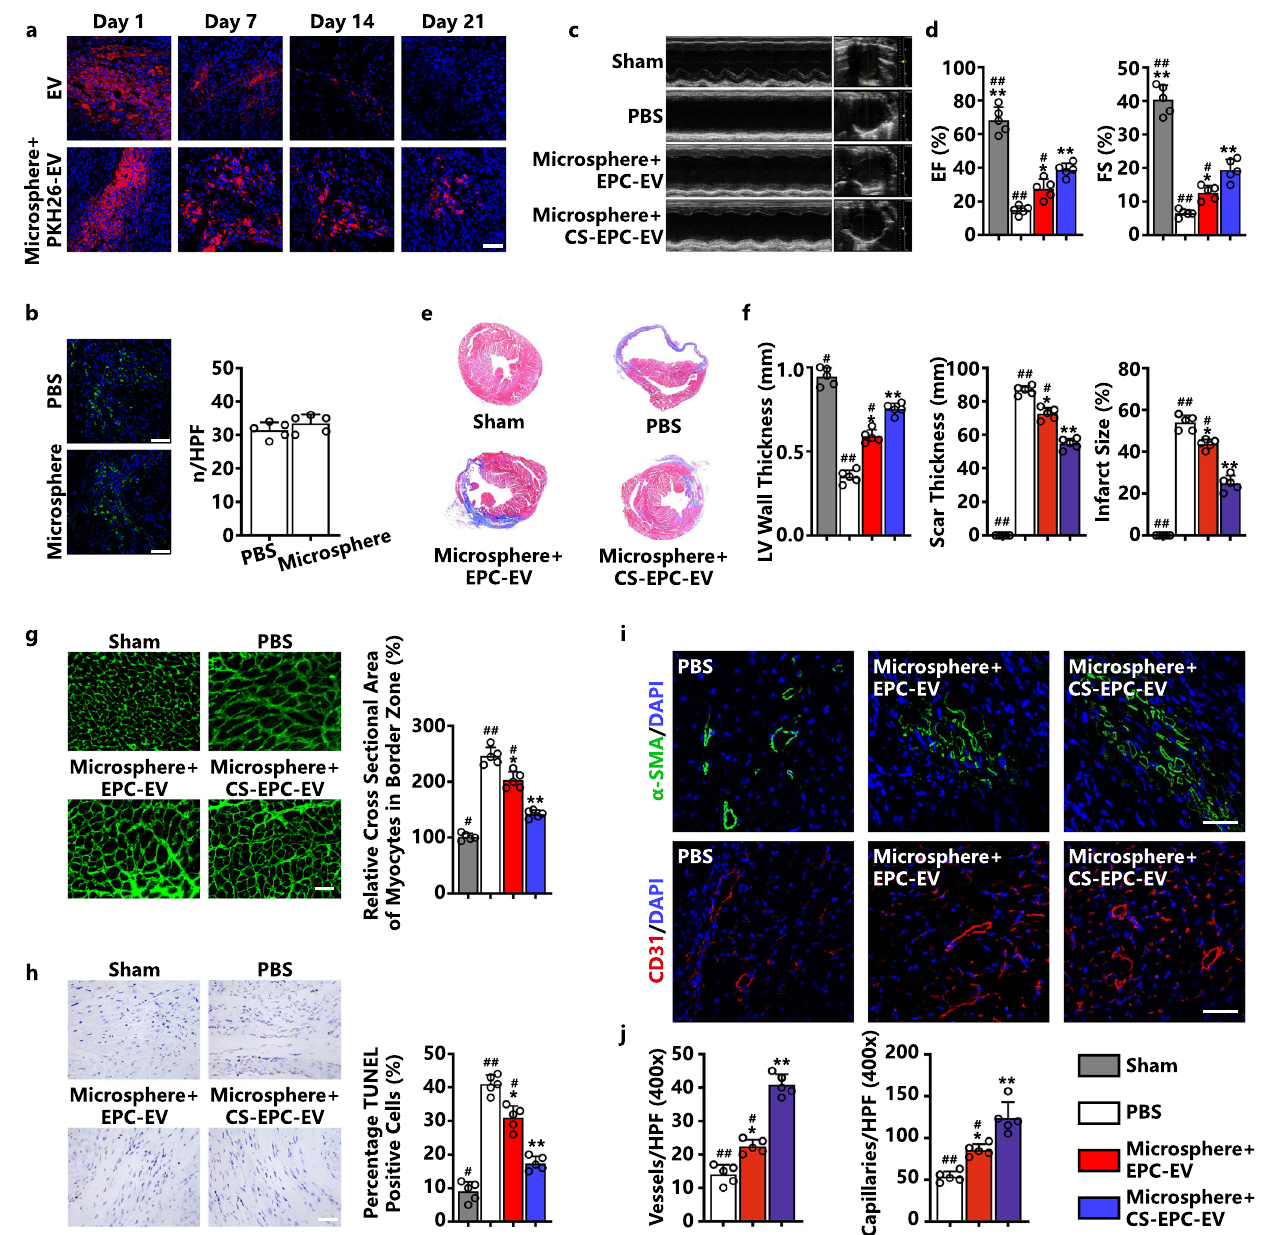
Fig.5|Microsphere+CS-EPC-EVscanimprovecardiacfunctionaftermyocardial infarction, reduce cardiac remodeling, inhibit cardiomyocyte apoptosis, and increase angiogenesis ( n =5, biological replicates per group). a Confocal fl uorescence microscopy images of PKH26-EV-encapsulated microspheres in the area of mouse myocardial infarction at 1, 7, 14, and 21 days, Scale bar=50 μ m. PKH26-EV (red fl uorescence), DAPI (blue fl uorescence). b CD68 immuno- fl uorescence staining of macrophages in cardiac tissue on Day 7 after myocardial infarction, Scale bar=50 μ m. CD68 (green fl uorescence) and DAPI (blue fl uores- cence). Quantitative analysis of the number of CD68-positive cells. c M-mode ultrasound images on Day 21 after myocardial infarction. d Quanti fi cation of the ejection fraction (EF) and fractional shortening (FS) of the animals on Day 21 after myocardial infarction. e Masson staining of hearts on Day 21 after myocardial infarction. f Statistical analysis of left ventricular wall thickness, scar thickness and infarct size. The number of hearts=5. g Wheat germ agglutinin immuno- fl uorescence staining of myocardial cells in the marginal zone of myocardial infarction on Day 21 after myocardial infarction, scale bar=50 μ m. Cross-sectional